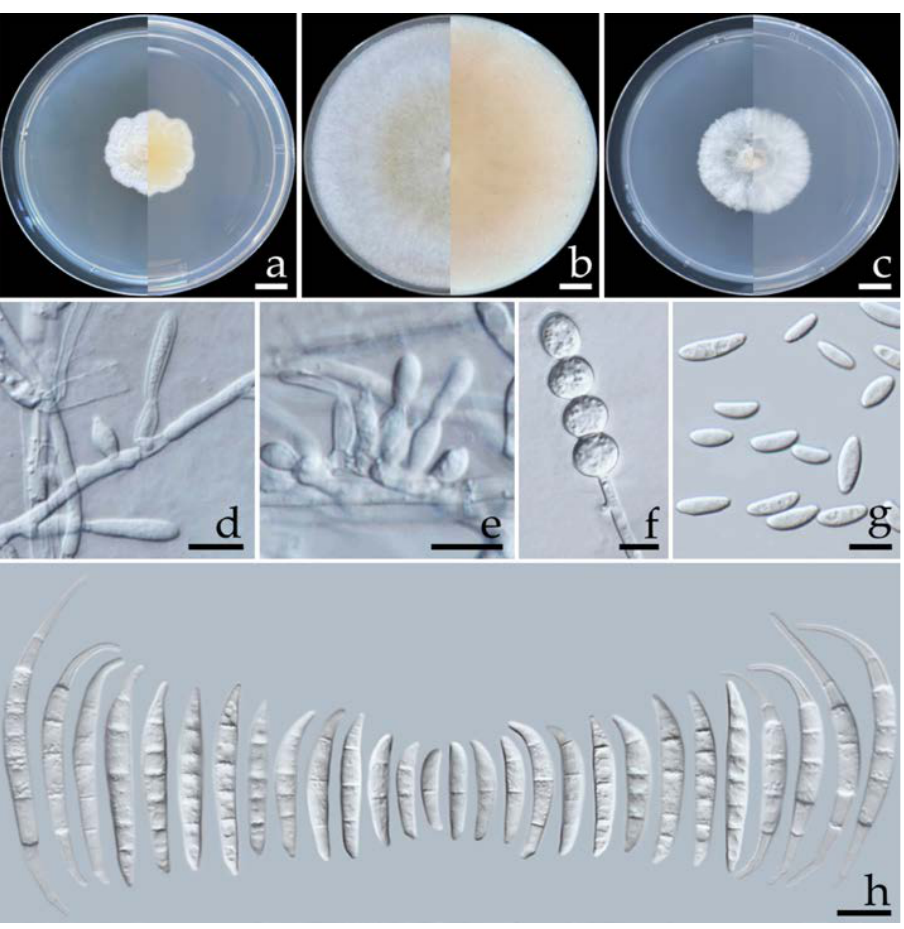
Figure 4. Fusarium compactum (SDBR-CMU461). Colony on potato dextrose agar ( a ), oatmeal agar ( b ) and synthetic nutrient-poor agar ( c ) (left, surface view and right, reverse view) after incubation at 25 °C for seven days. Phialides on aerial mycelium ( d , e ). Chlamydospores ( f ). Aerial microconidia ( g ). Aerial macroconidia ( h ). Scale bars: ( a – c ) = 10 mm; ( d – h ) = 10 µm.